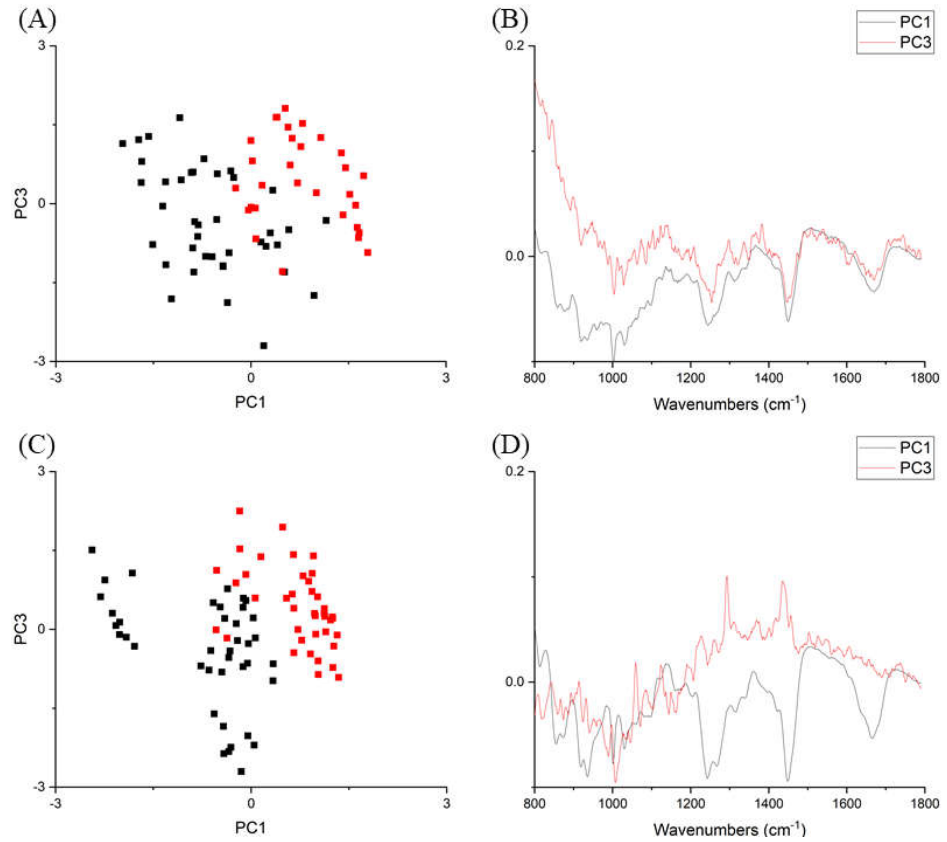
Figure 3. Principal component analysis on min–max normalised spectra. ( A ) SDFT, scatter plot of PC1 and PC3 axis. Red squares : young tendons; black squares : old tendons. ( B ) SDFT, PC1 (black line) and PC3 (red line) vector loading plot. ( C ) DDFT, scatter plot of PC1 and PC3 axis. Red squares: young tendons; black squares : old tendons. ( D ) DDFT, PC1 (black line) and PC3 (red line) vector loading plot.